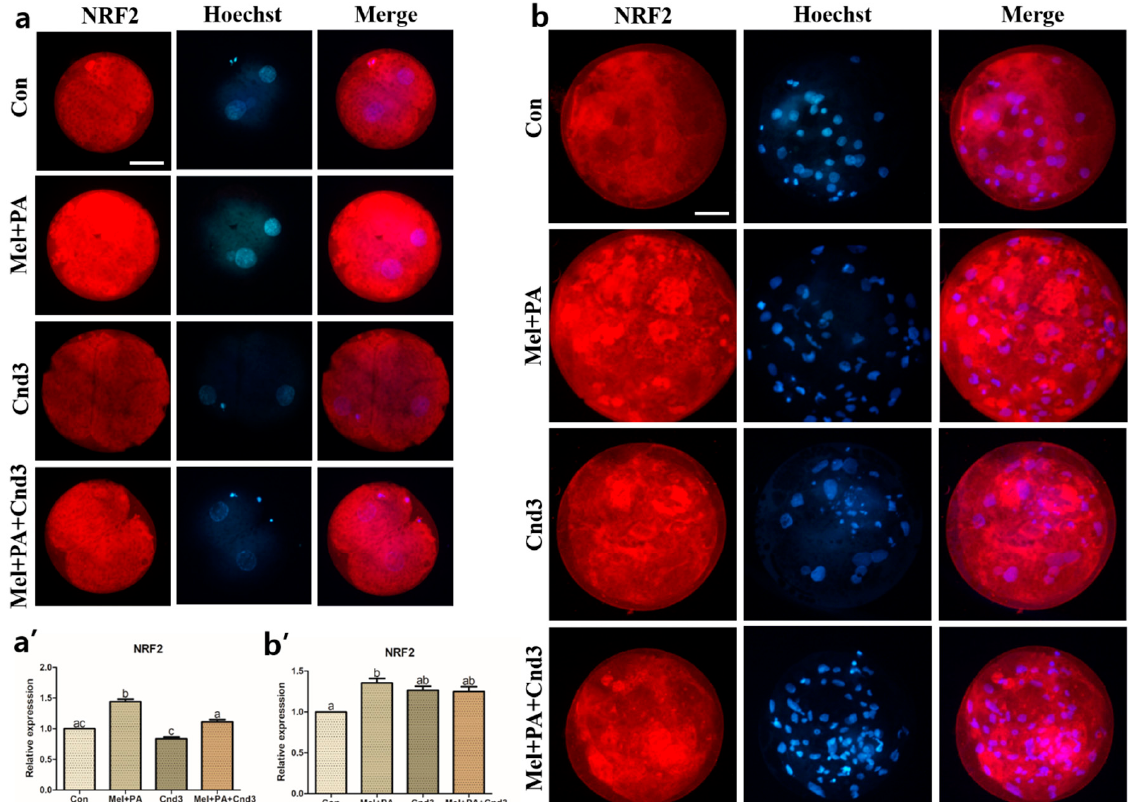
Figure 4. Representative images of immunocytochemical analysis of NRF2 in porcine two-cell embryo blastocysts. Fluorescence microscopy was applied to obtain images of embryos. ( a , b ) Representative two-cell embryos in each group were stained with NRF2 rabbit-derived antibody and counterstained with Hoechst 33342. ( a’ , b’ ) Analysis of intensities from NRF2-stained two-cell embryos and blastocysts. At least 20 two-cell embryos and 15 blastocysts from five biological replications in each group were used for the staining and immunocytochemistry was performed three times technically. Data are shown as the means ± SEM. Bars with different alphabetical letters are significantly different ( p < 0.05). Con, control; mel, melatonin, PA, phytanic acid; Cnd3, siRNA candidate 3. White bars in the images indicate 50 μ m; 400× magnification.